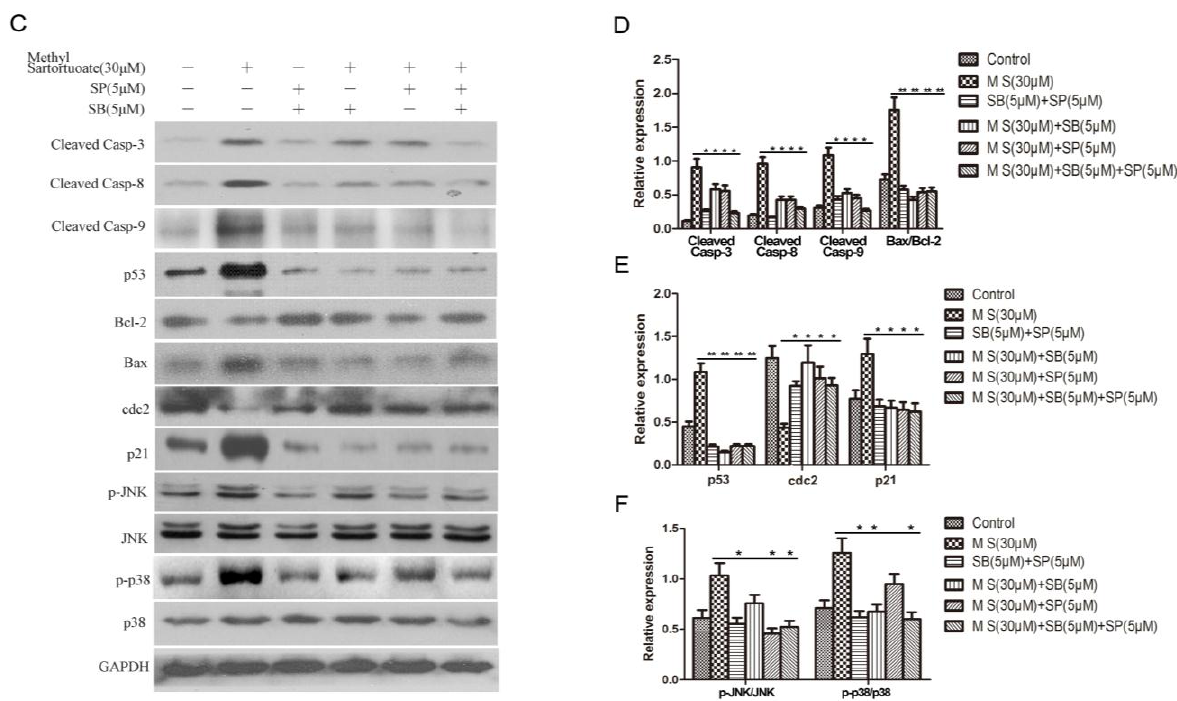
Figure 6. Methyl Sartortuoate induced LoVo cells apoptosis by activated JNK and P38 pathway. ( A , B ) Cell cycle distribution was examined by flow cytometric assay method ( n = 3). * p < 0.05 versus indicated group; ( C – F ) LoVo cells were pre-incubated for 1 h in the presence or absence of SP600125 (5 mM), SB203580 (5 mM), and then treated with 30 µmM Methyl Sartortuoate for 24 h, followed by western blotting analysis of apoptosis-related proteins and cell cycle-related proteins. SP, SP600125, SB, SB203580, M S, Methyl Sartortuoate. The relative expression of band for apoptosis-related proteins, cell cycle-related proteins and p-p38, p-JNK proteins indicated by Western blots, and the bar is the standard deviation ( n = 3). * p < 0.05 and ** p < 0.01 versus control group.